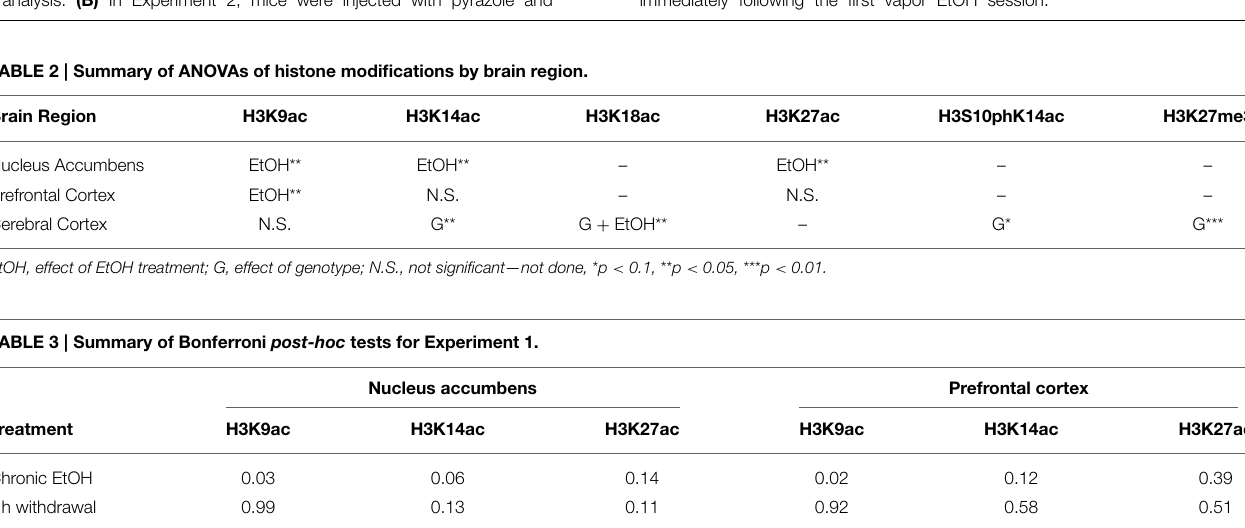
FIGURE 1 | Experimental Design. (A) In Experiment 1, mice were injected with either 1g/kg EtOH or saline then immediately placed into a vapor EtOH chamber or room air for 16h overnight (1700 to 0900) for 4 consecutive days; they were sacrificed immediately following the final vapor EtOH exposure (chronic EtOH), 8h following the final vapor EtOH exposure (8h withdrawal), or 72h following the final vapor EtOH exposure and their NAc and PFC were flash frozen and stored for analysis. (B) In Experiment 2, mice were injected with pyrazole and